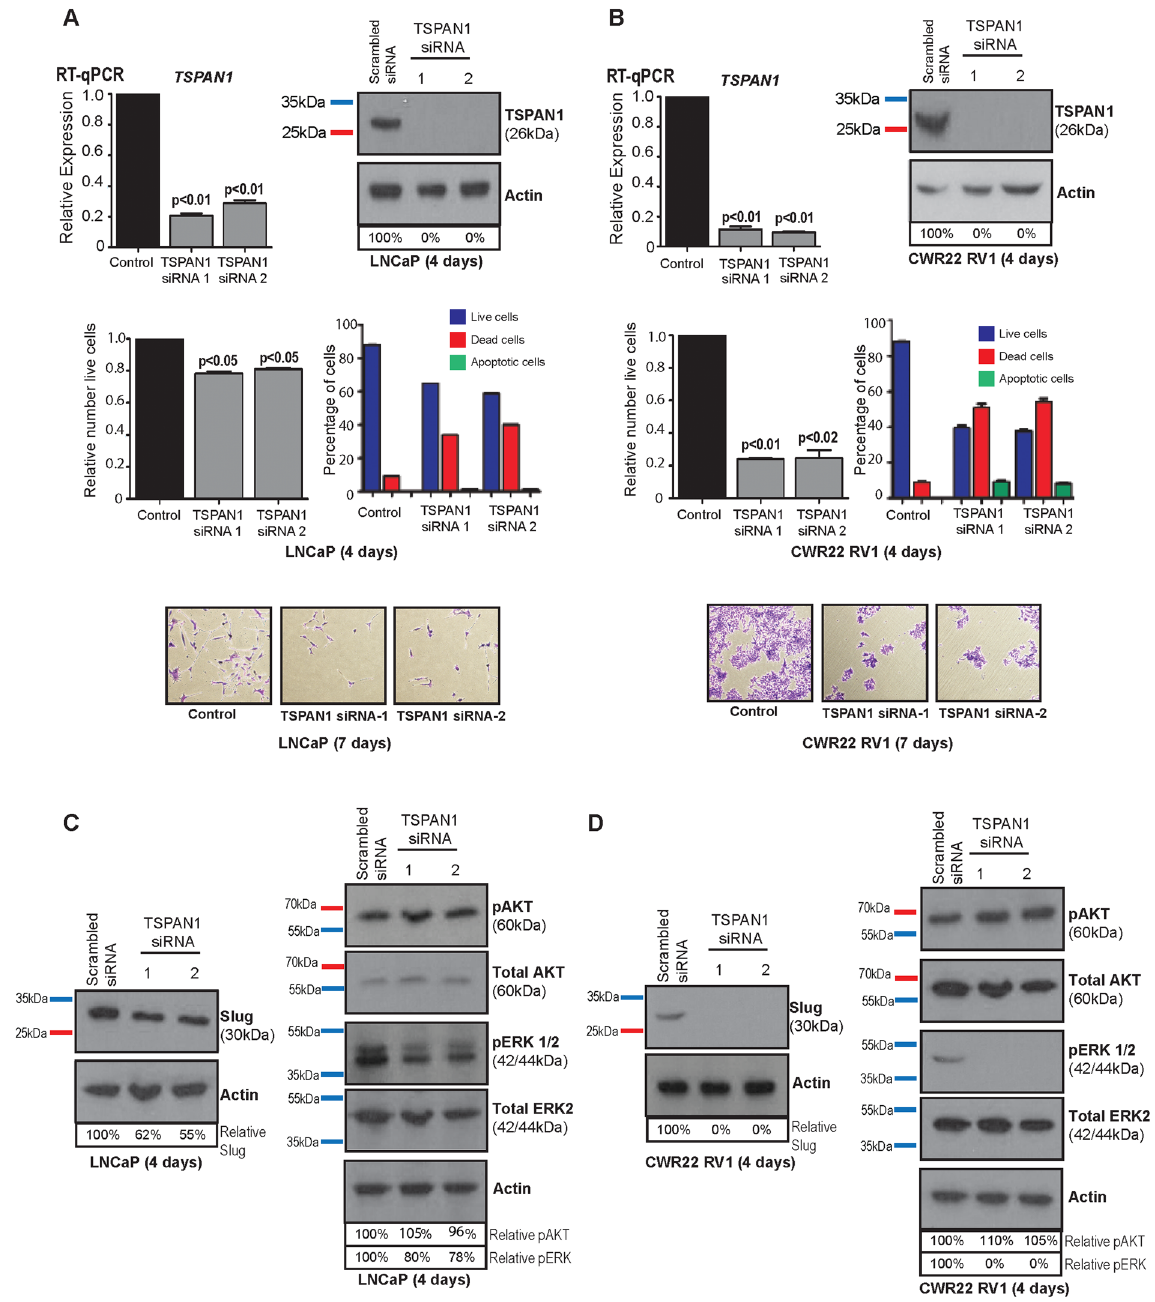
Figure 4. TSPAN1 is essential for prostate cancer cell viability. Depletion of TSPAN1 in (A) LNCaP and (B) CWR22 RV1 cells by transient transfection with siRNA. Protein depletion was carried out using two different siRNAs in cells grown in full media. 96 hours after transfection knockdown of TSPAN1 was confirmed by real-time PCR and western blot and the relative number of live cells was calculated. Representative crystal violet stained images are shown below for each cell line after 7 days (due to a dramatic decrease in cell viability we were unable to harvest enough live cells to confirm TSPAN1 knockdown after 96 hours). (C) Western blot analysis of various proteins in LNCaP and (D) CWR22 RV1 cells following siRNA mediated protein depletion of TSPAN1 for 96 hours. Please note: cropped western blots are displayed in the figure, but full length blots are included in the Supplementary Information